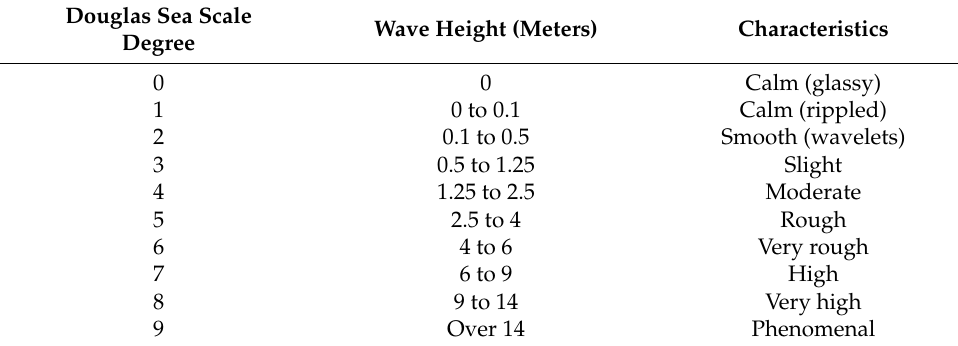
Table 4. The world Meteorological Organization’s Douglas Sea